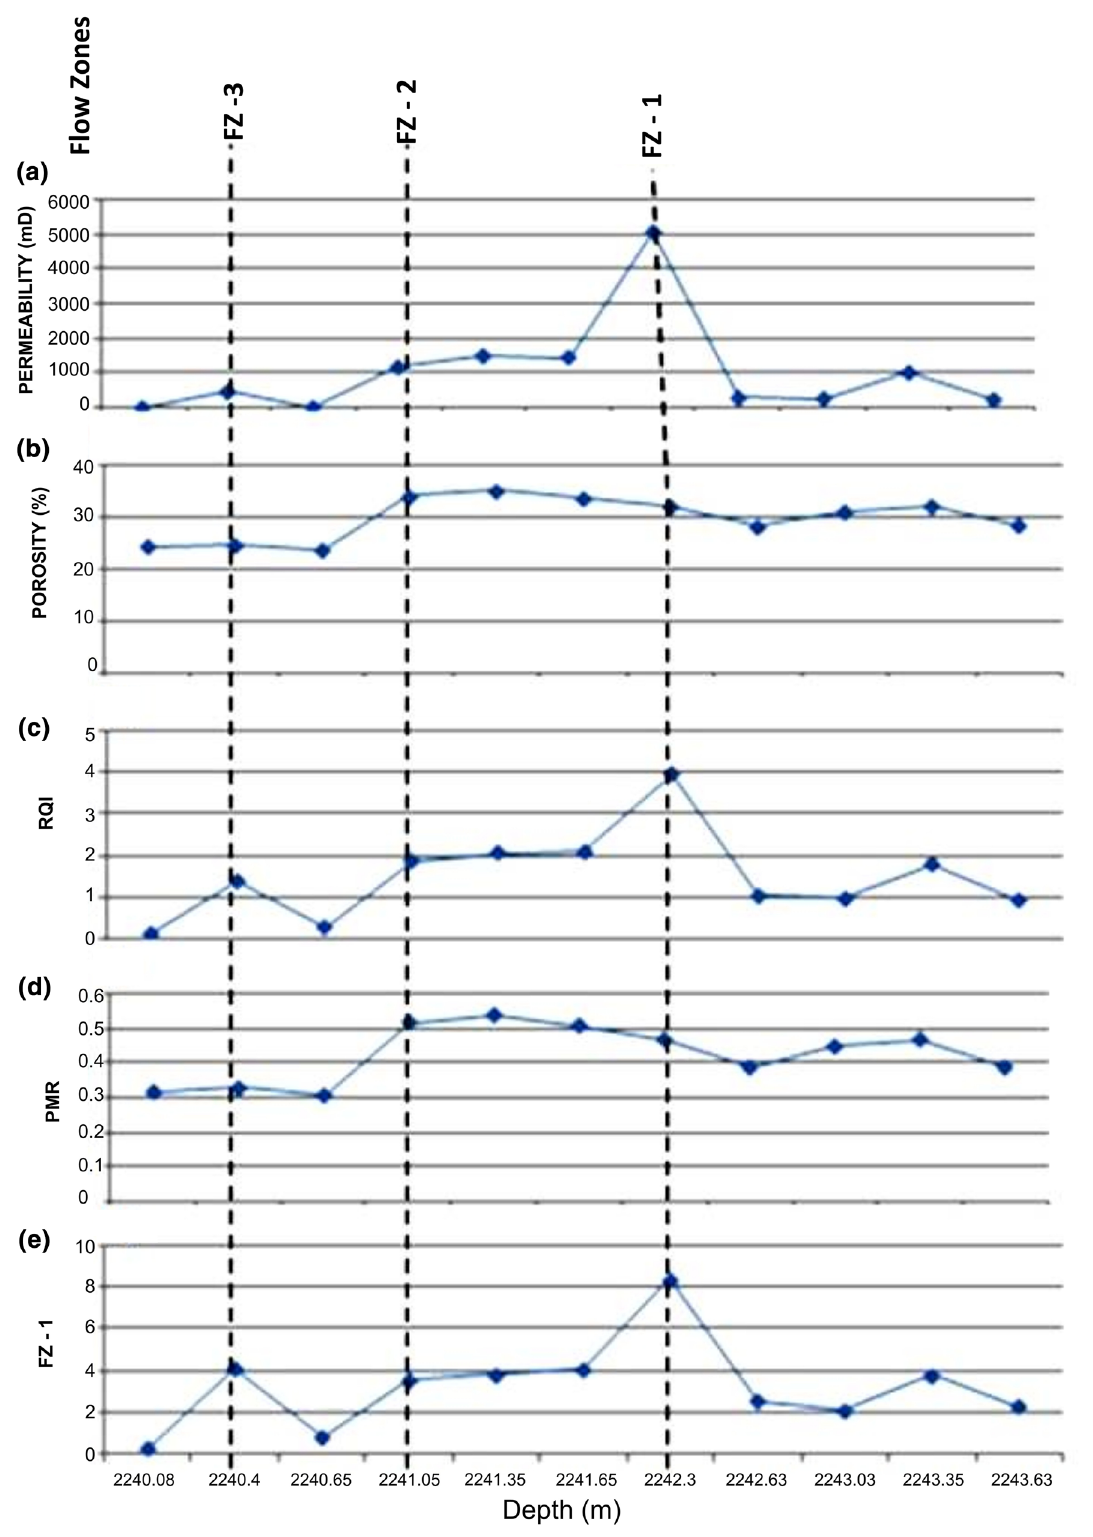
Fig. 8 Hydraulic flow units in the PZ-4